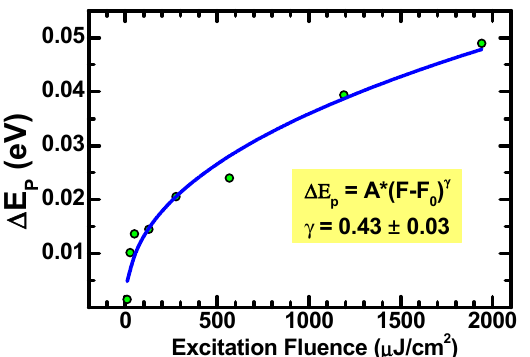
Figure 2. Shift of PL peak energy vs. excitation fluency F. The data are obtained by the measurements reported in Figure 1 and the “zero value” of the shift refers to the low fluence measurement obtained via the use of an HeCd laser. The blue curve is a best fit of the data obtained through the function in Equation (9).